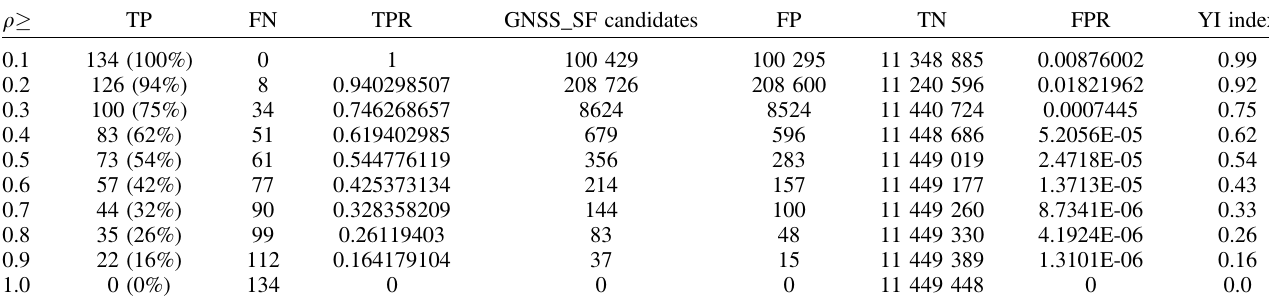
Table 2. Contingency table for several threshold values of the correlation